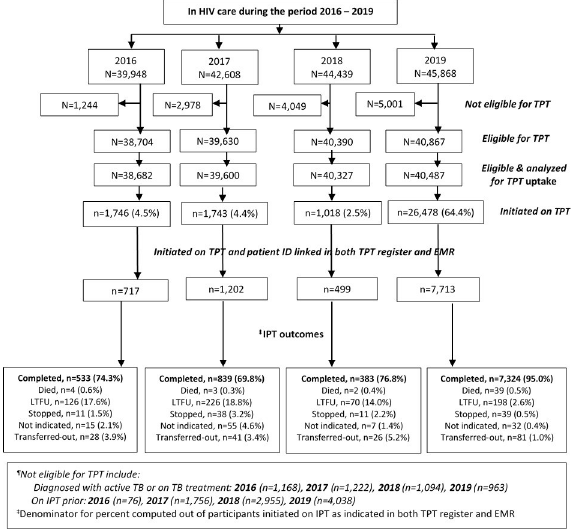
Fig 1. Patients’ flow diagram by the 4 years studied at the 6 health facilities. 1) Eligible & analyzed for TPT uptake excluded the PLHIV eligible documented in the paper-based TPT register but had no information in the EMR. These were excluded because participants’ characteristics were extracted from the EMR. Numbers excluded were: 22, 30, 63, 380 in 2016, 2017, 2018 and 2019 respectively. 2) Numbers initiated on TPT among total patients eligible for TPT by year and quarter: 2016Q1 (875/31,306), 2016Q2 (90/3,127), 2016Q3 (24/2,378), 2016Q4 (407/1,871), 2017Q1 (343/ 32,333), 2017Q2 (294/3,308), 2017Q3 (442/2,325), 2017Q4 (266/1,634), 2018Q1 (78/30,867), 2018Q2 (78/5,394), 2018Q3 (131/2,251), 2018Q4 (296/1,815), 2019Q1 (4,802/25,694), 2019Q2 (2,448/11,061), 2019Q3 (1,269/2,073), 2019Q4 (516/1,658). 3) Majority of patients were scheduled to return to the HIV clinic for review every after 3 months. Number of patients visited during the quarter don’t add up to the unique numbers visited during the